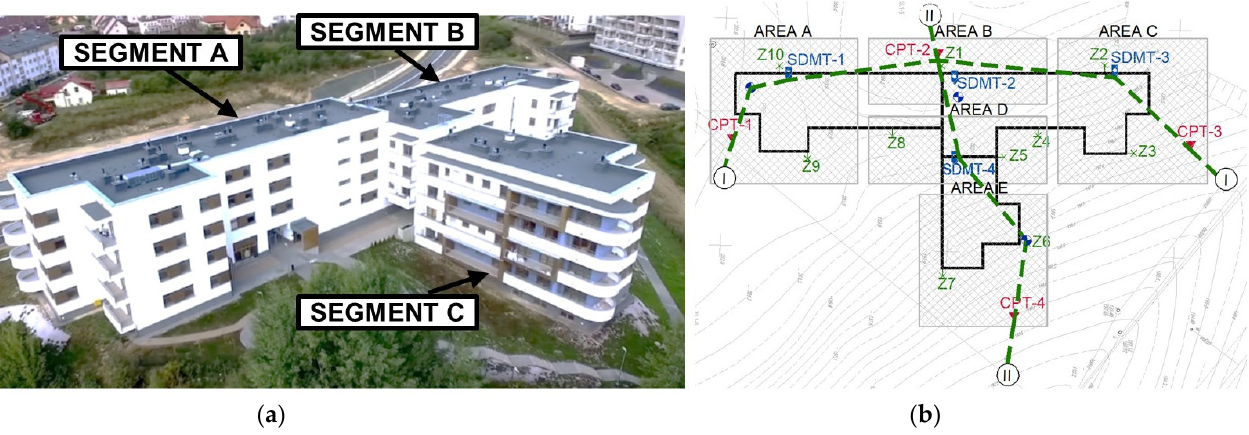
Figure 3. The analyzed building: ( a ) view of the real object [33]; ( b ) map with the location of geotechnical tests (CPT and SDMT), benchmarks (Z1 ÷ Z10) and division into computational areas (A ÷ E).